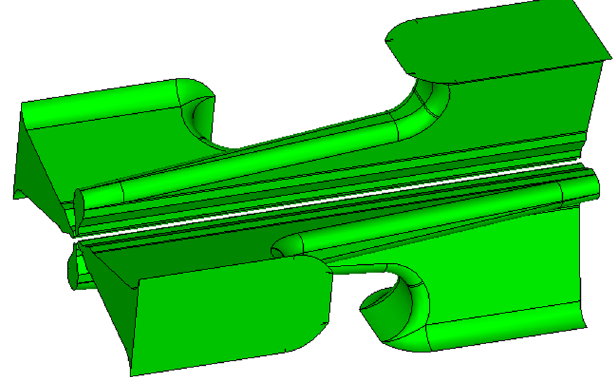
FIG. 12. MW-Studio model: RFQ vanes showing the alternat- ing window cuts between the horizontal and vertical